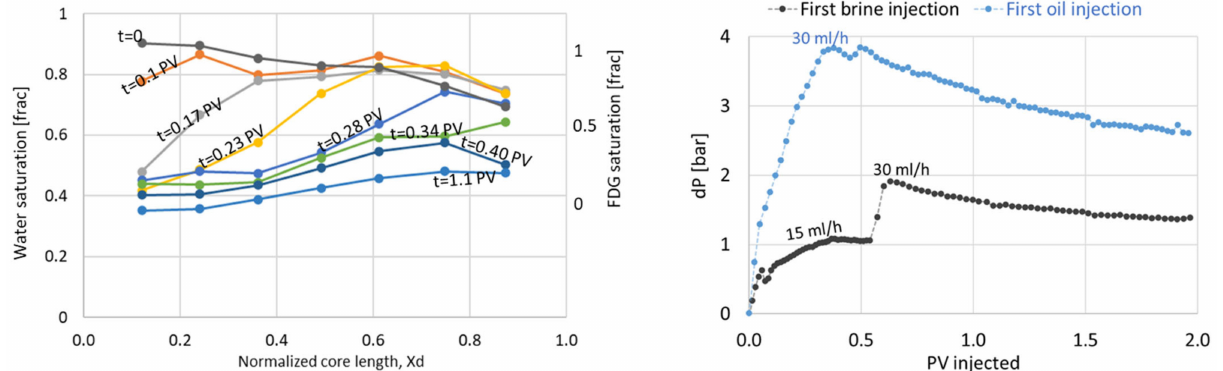
Figure 12. ( Left ) Saturation profiles during oil displacement in core L27. ( Right ) Pressure profiles during the first water and oil floods in core L27.